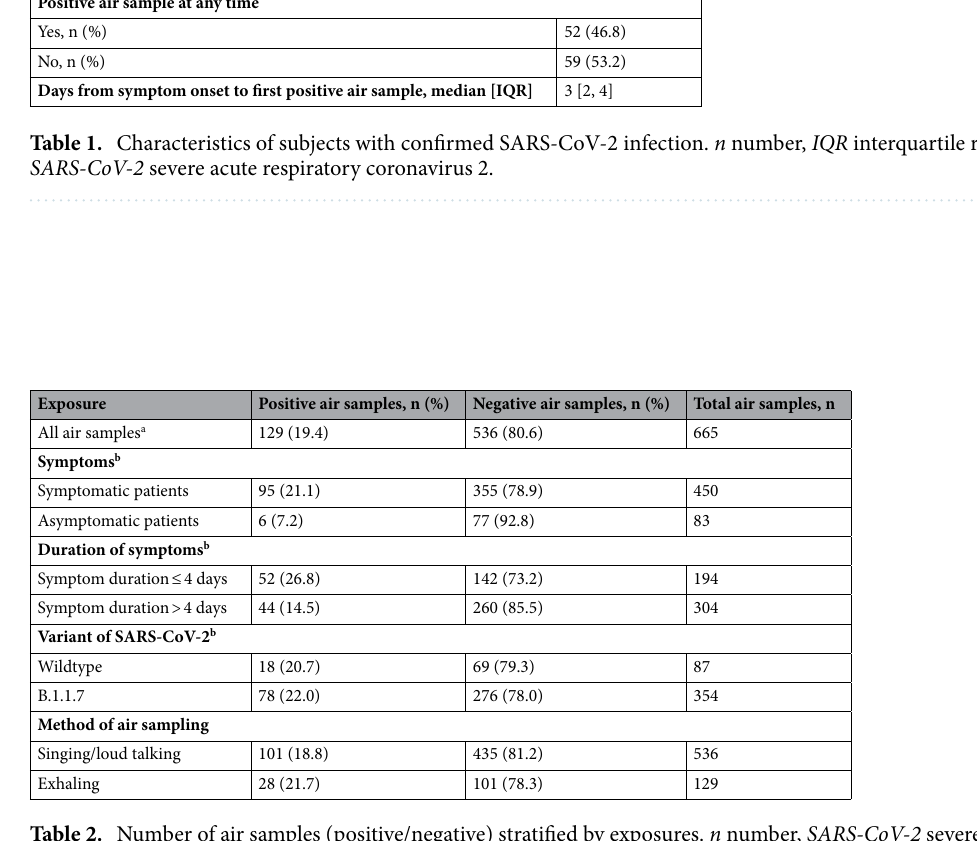
Table 2. Number of air samples (positive/negative) stratified by exposures. n number, SARS-CoV-2 severe acute respiratory coronavirus 2. a Obtained through singing/loud talking and exhaling. b Obtained through singing/loud